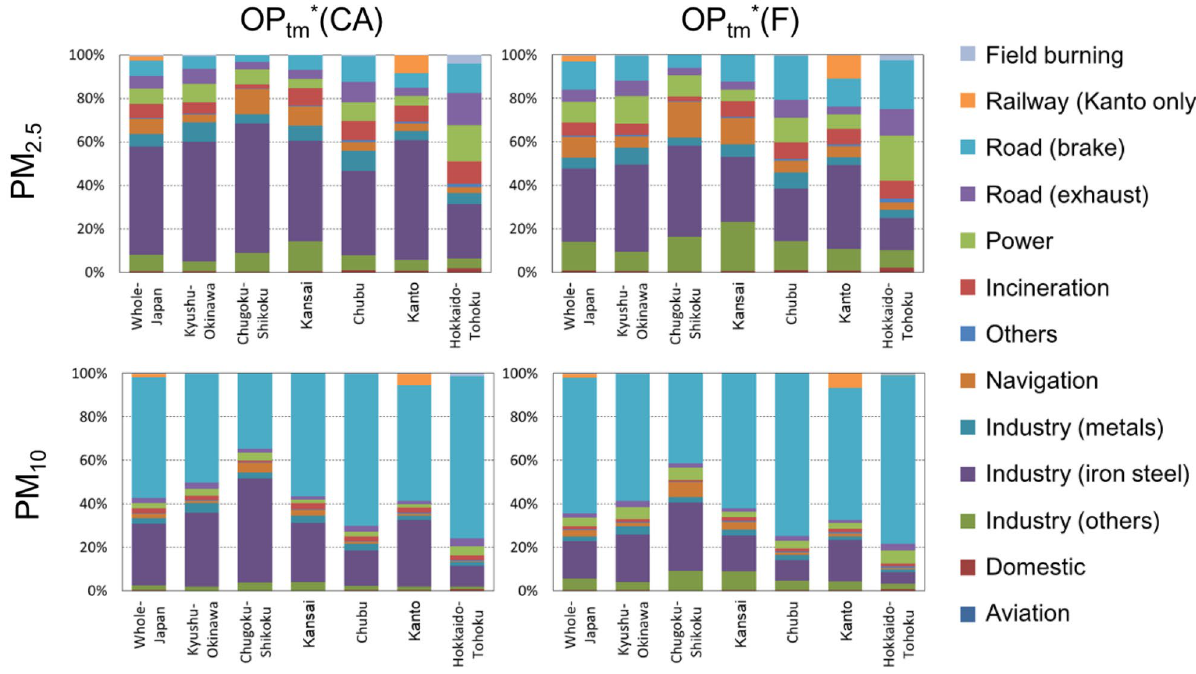
Figure 6. Relative contributions of the emission sectors to OP tm *. Contributions of each anthropogenic emission sector in TMI-Japan (v1.0) to OP tm *(CA) and OP tm *(F) in regard to PM 2.5 and PM 10 over all of Japan and the six regions, as shown in Fig. 1. Note that TMI-Japan (v1.0) provides railway emissions only for